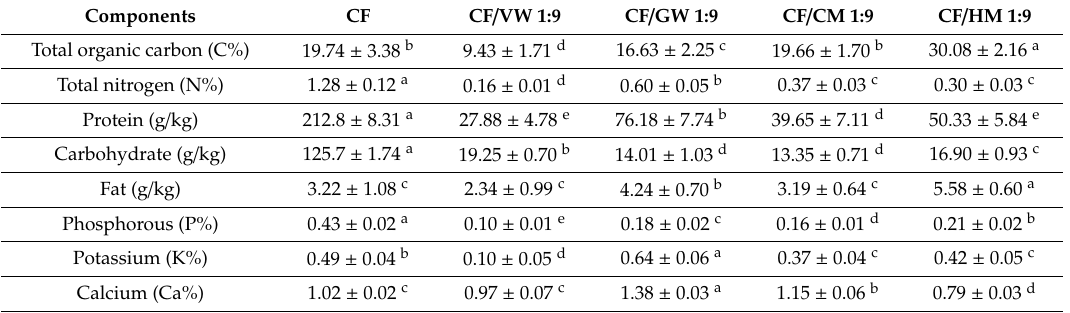
Table 1. Nutrient composition of the substrates used as diets for rearing Zophobas morio , Tenebrio molitor, and Acheta domesticus larvae.